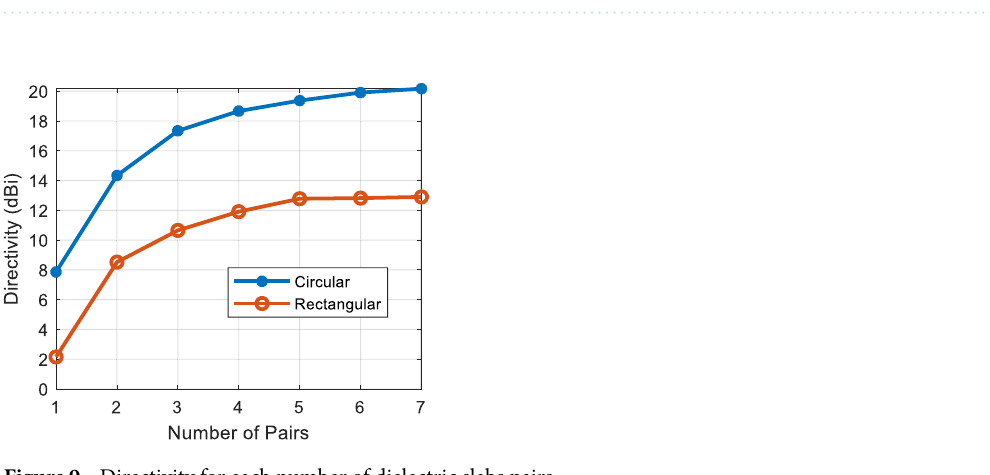
Figure 8. Electric field heat map of the proposed structure in Fig. 7, ( a ) isometric view, ( b ) top view, ( c ) h-plane cut, and ( d ) backed by PMC, scale (V/m).